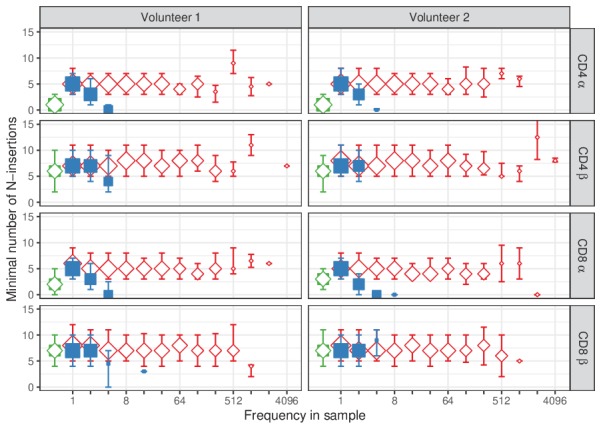
TCRα and TCRβ sequences abundant in naive tend to have less N-insertions.For each sequence σ in our dataset of single samples, the minimal number of N-insertions was determined by the length of the CDR3 nucleotide sequence not matching germline TRAV and TRAJ (for TCRα), or TRBV, TRBD and TRBJ (for TCRβ). The median insertion length is shown for each observed frequency class (log2 bins) in naive (blue squares) and memory T-cell (red diamonds) samples. Insertion length of the overlapping TCR sequences is shown in green for reference (irrespective of frequency). Symbol sizes indicate numbers of sequences for each frequency class. Error bars represent the 25% and 75% quartiles.